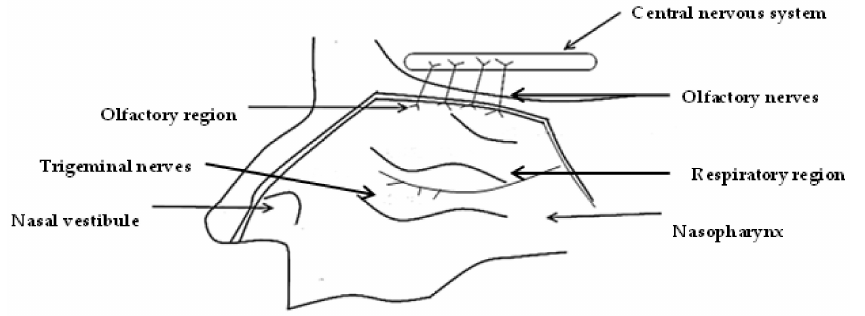
Figure 2. Image of the different areas of the nasal cavity (Adapted with permission from [52].